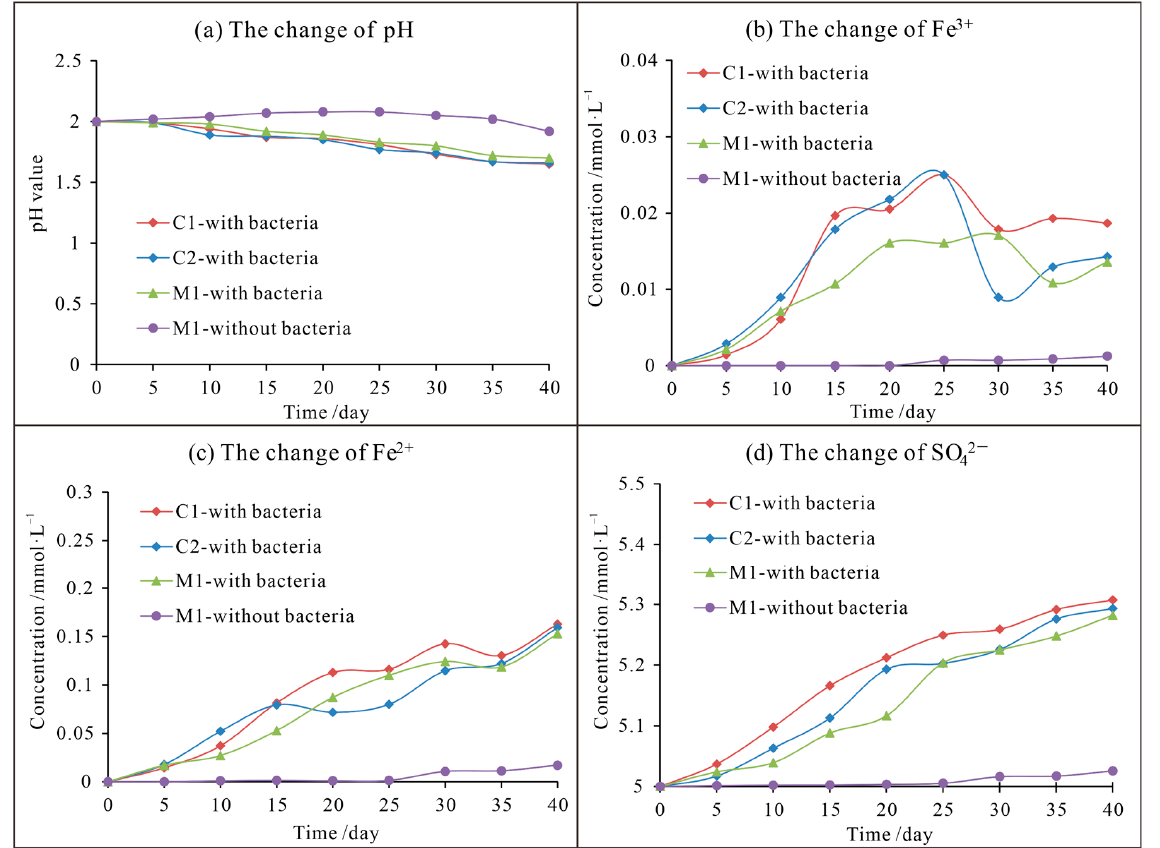
Figure 8. The change of pH value and component concentration in reaction solution with bacteria: ( a ) is the change of pH value; ( b ) is the change of Fe 3+ concentration; ( c ) is the change of Fe 2+ concentration; ( d ) is the change of SO 42 − concentration.